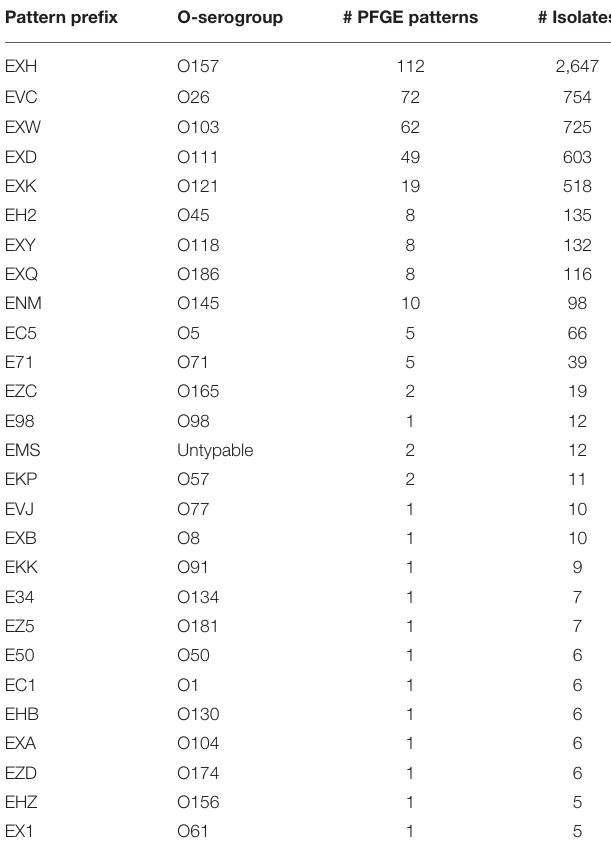
TABLE 1 | Distribution of PFGE patterns and isolates from each O-antigen serogroup analyzed in this